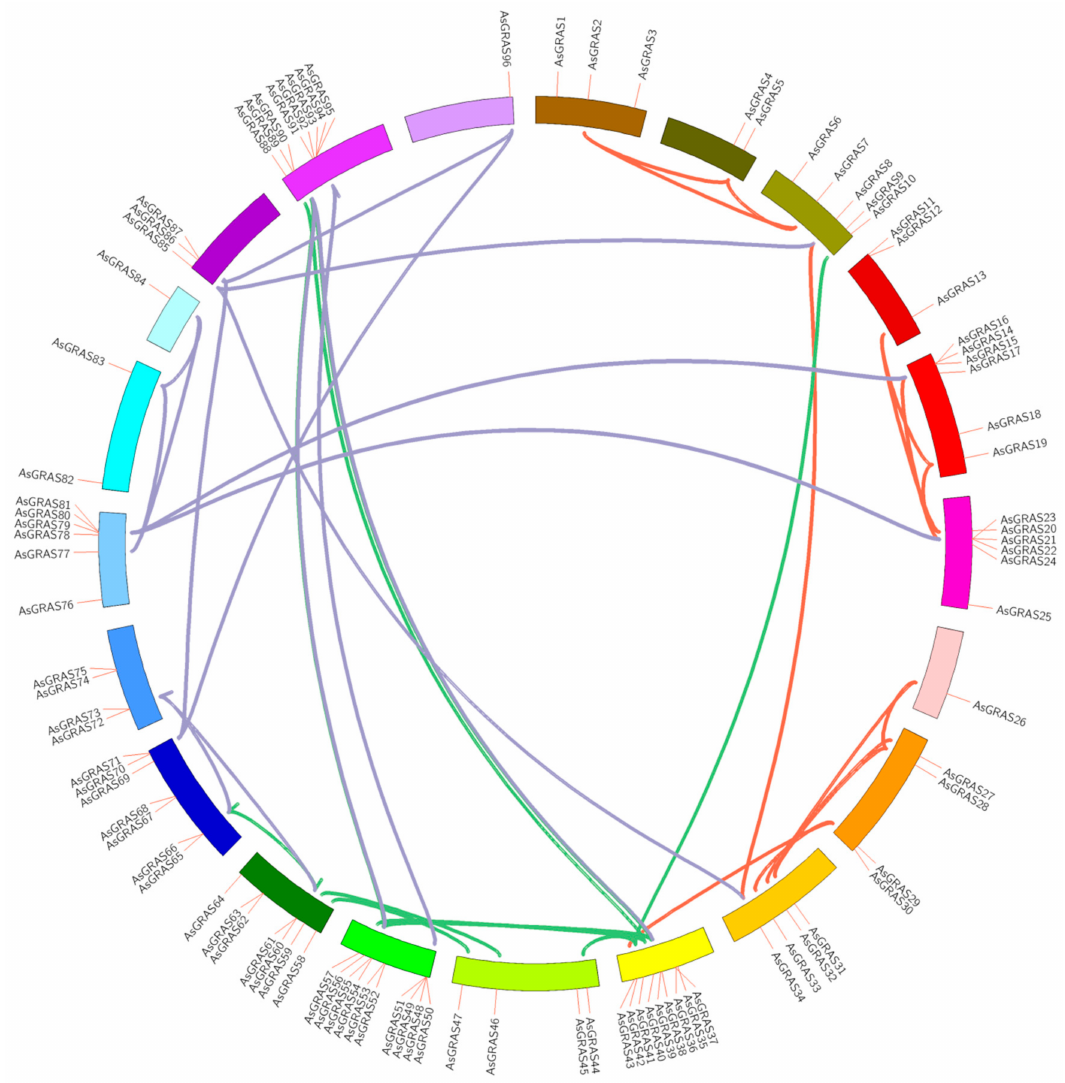
Figure 3. Analysis of the promoter elements of the GRAS gene family in Avena sativa